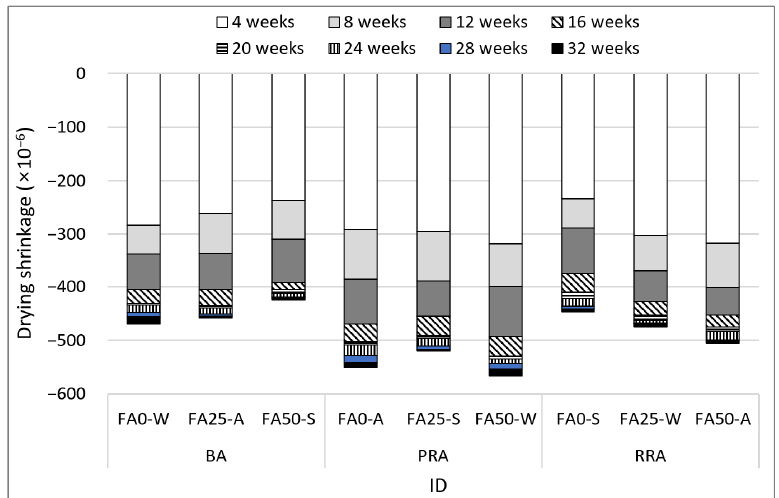
Figure 12. Drying shrinkage of concrete.